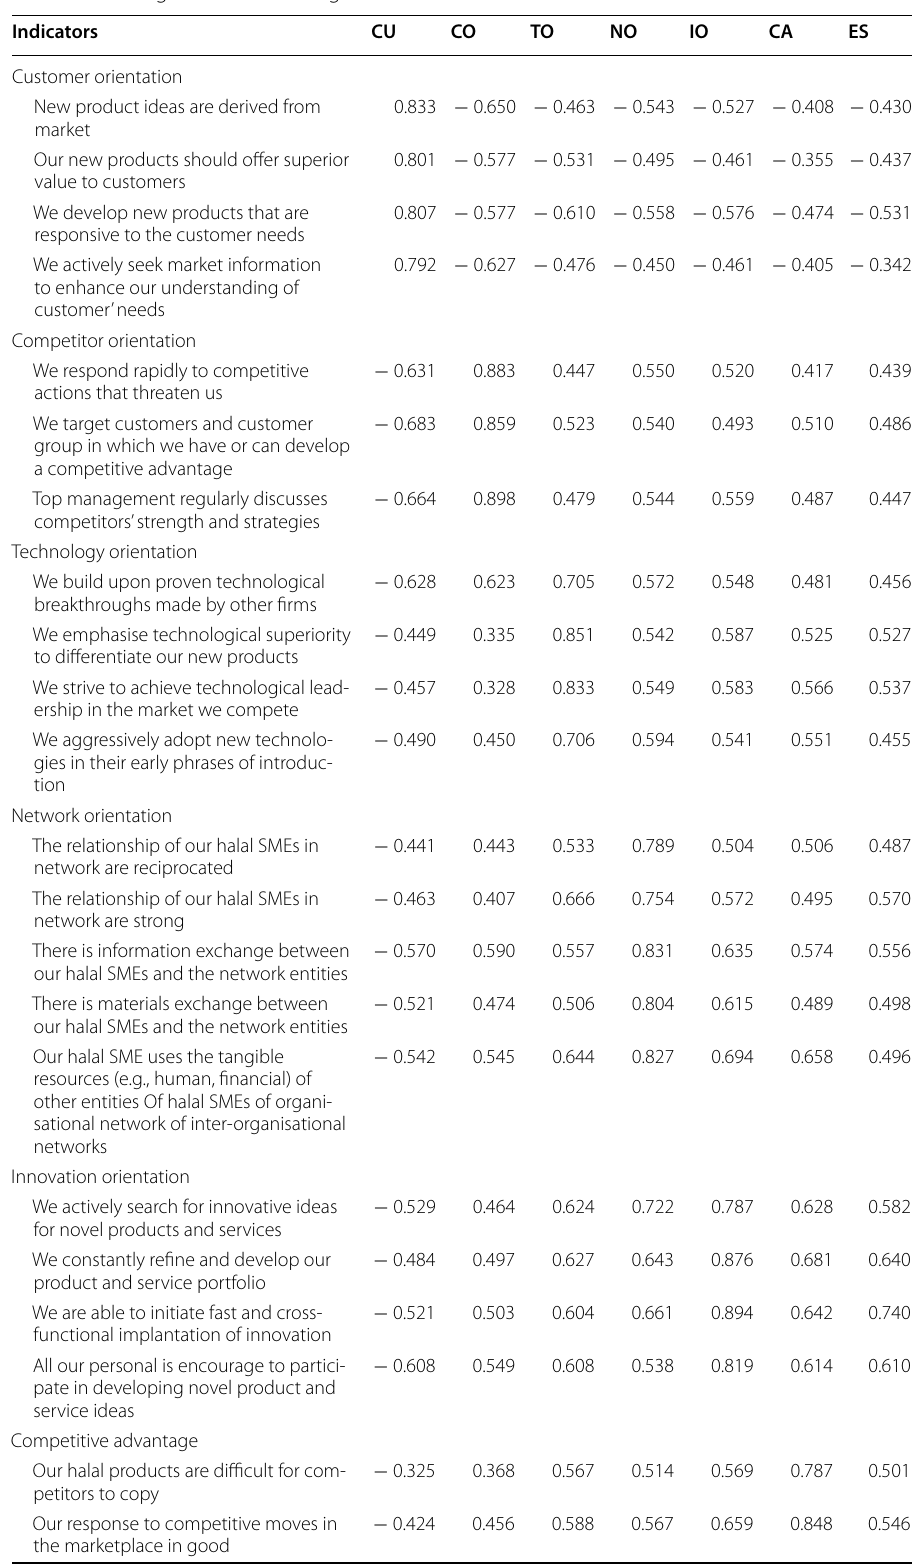
Table 4 Loadings and cross-loadings